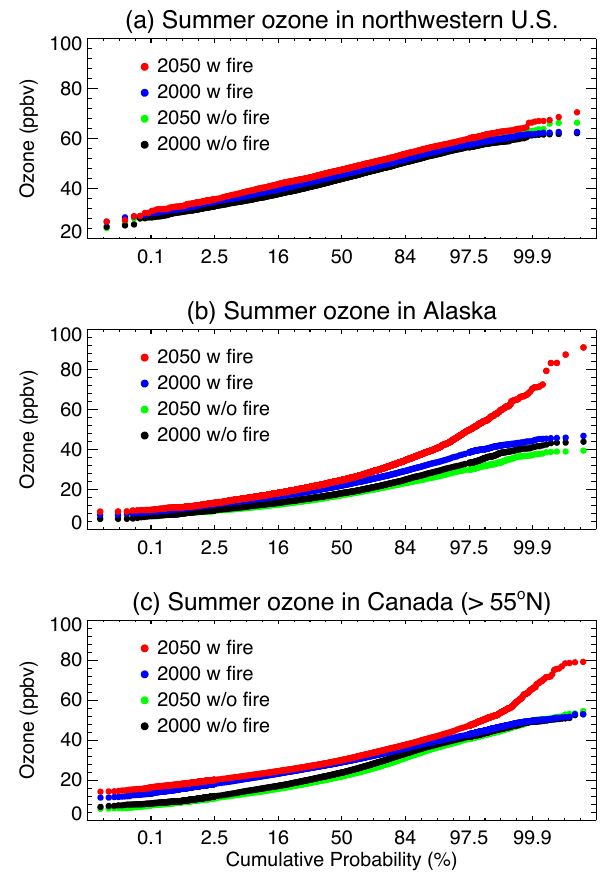
Figure 11. Simulated cumulative probability distributions of MDA8 ozone at the surface in summer (June–August) over (a) northwest- ern US (>40 ◦ N), (b) Alaska, and (c) Canada (>55 ◦ N) for different scenarios. Black shows the present-day (1997–2001) climate with- out wildfire emissions; green shows future (2047–2051) climate without wildfire emissions; blue indicates present-day climate in- cluding the associated wildfire emissions; and red indicates future climate including the associated wildfire emissions. Each point rep- resents the value in one grid square within each region for each day during the five model summers (1997–2001 or